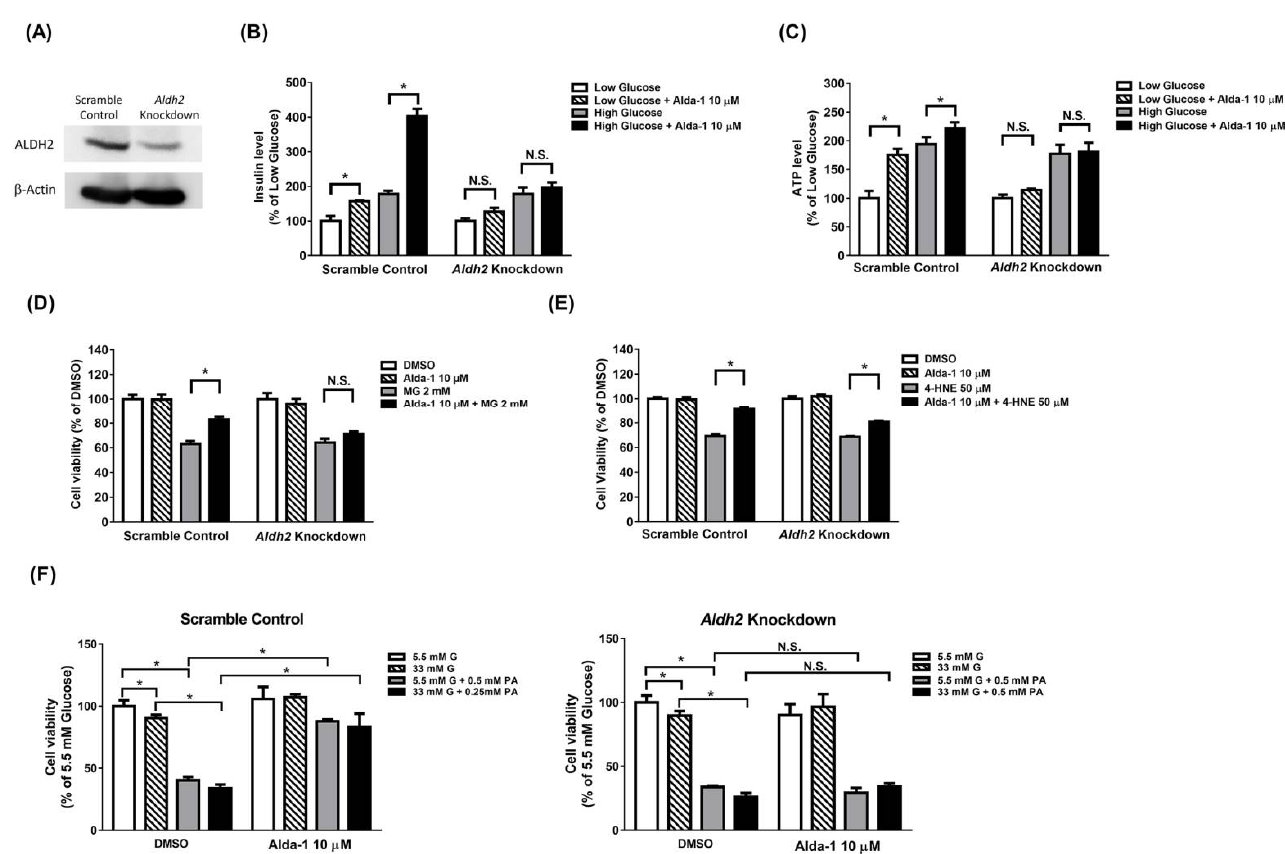
Figure 5. Aldh2 knockdown abolished the anti-apoptotic effects of ALDH2 activator in MIN6 cells. ( A ) The knockdown efficiency of shRNA on ALDH2 expression was analyzed by Western blot. Effect of Alda-1 on scramble control and Aldh2 knockdown MIN6 cells on ( B ) Insulin secretion and ( C ) ATP levels in low (3.3 mM) and high glucose (16.7 mM) concentrations. Effect of Alda-1 on cell viability in the presence of ( D ) 2 mM methylglyoxal (MG) or ( E ) 50 µ M 4-HNE. Data are presented as mean ± SEM ( n = 3 per group). ( F ) Incubation in either high glucose or palmitate alone or with both combinations, to evaluate the direct toxic effects of glucolipotoxicity and the protective effect of Alda-1. The data were normalized to 5.5 mM glucose as the control and represented as percentage of viability. ( n = 4–6 per group). G: glucose, PA: palmitate. *: p < 0.05. N.S.: not